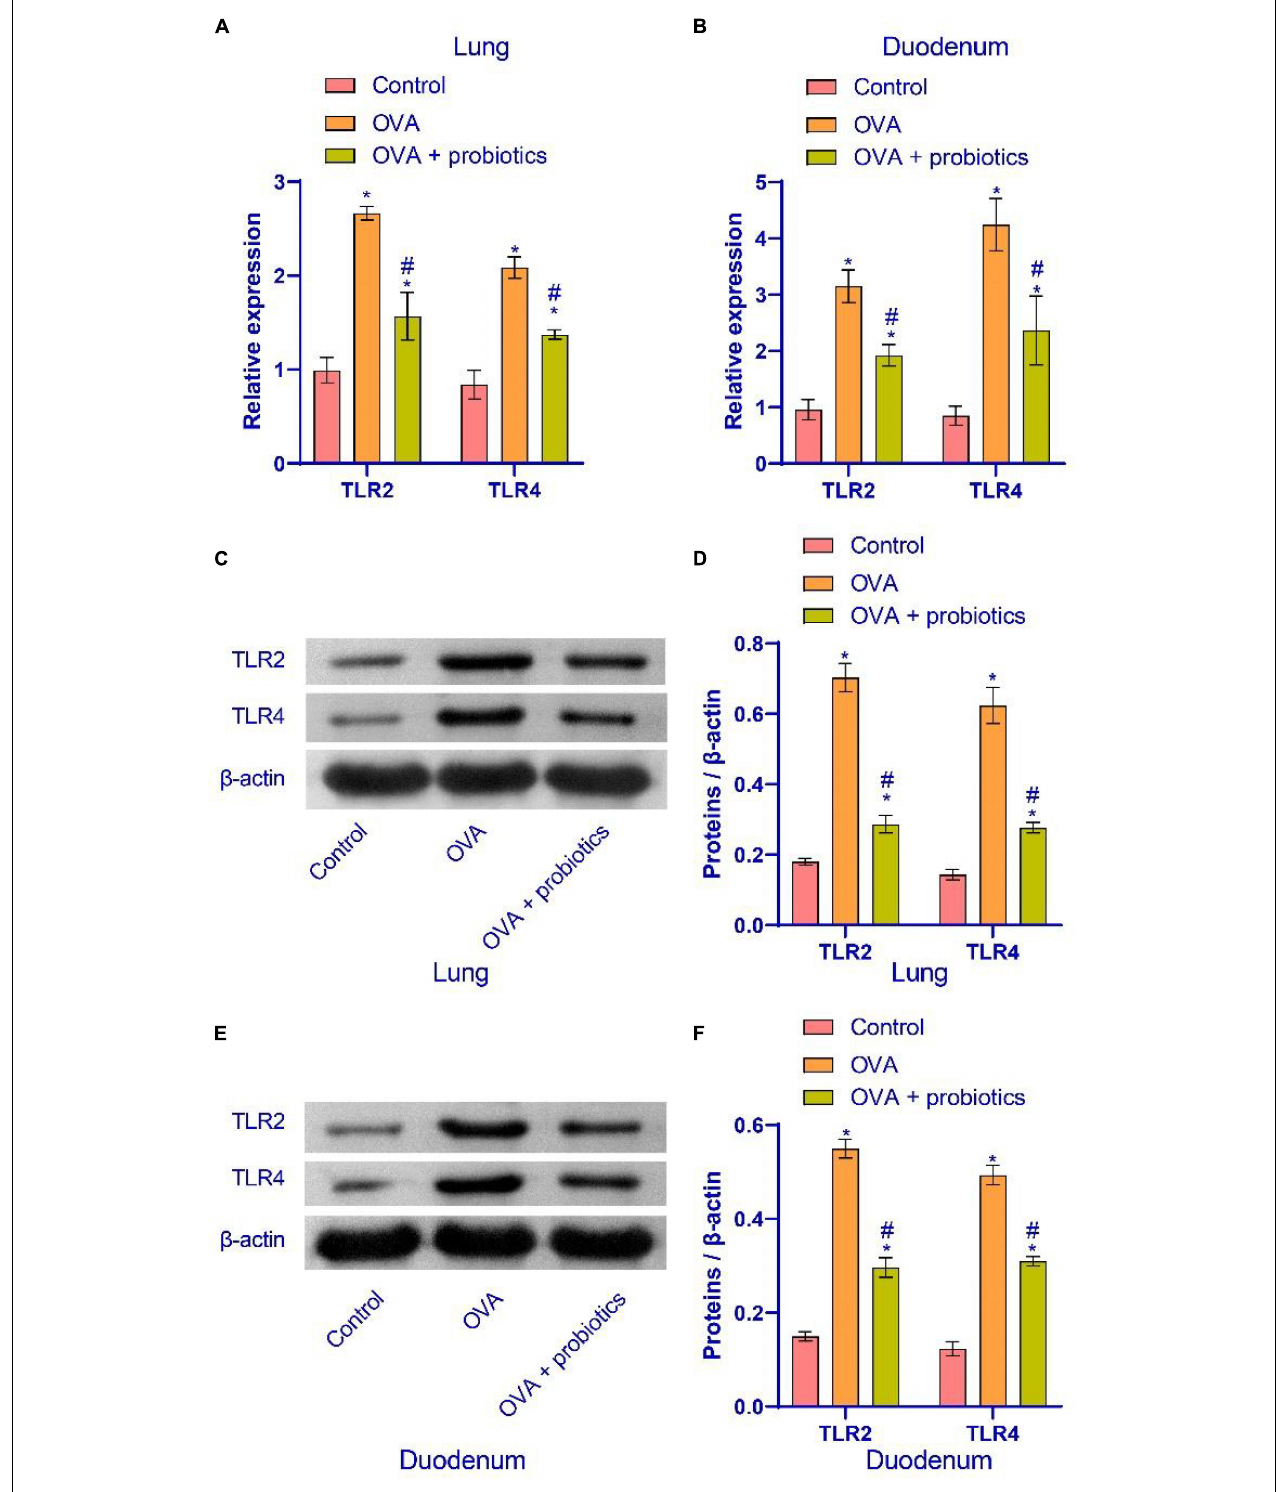
FIGURE 5 | Supplementation with Lactobacillus fermentum CECT5716 could inhibit the TLR2/TLR4 expression. (A,B) qRT-PCR was used to detect the expression of mRNA. Lactobacillus supplementation could reduce the mRNA expression of TLR2 and TLR4. (C–F) Western blot was used to measure the expression of proteins. Lactobacillus supplementation could inhibit the protein expression of TLR2 and TLR4. *Compared with the control group, P < 0.05. # Compared with the OVA group, P < 0.05. One-way ANOVA was used among multiple groups. n = 5 for each group.